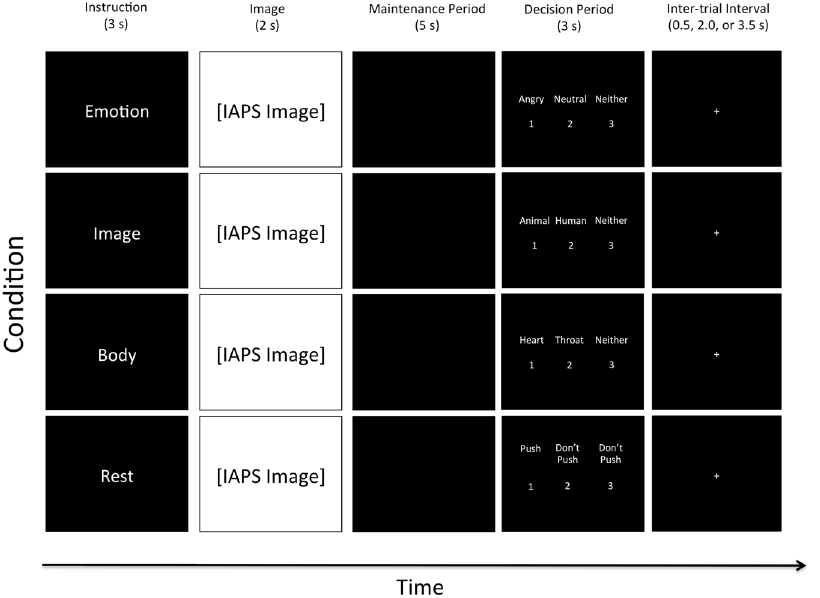
Figure 1. Illustration of the four task conditions. After the appearance of each instruction, an emotionally pleasant, unpleasant, or neutral image (from the International Affective Picture System [IAPS]) was presented followed by a maintenance period. All contrasts reported in this manuscript compare the 5-second maintenance periods between the “Emotion,” “Image,” and “Rest” conditions. Analyses of the “Body” condition will be presented in a separate manuscript. The decision period that followed included making a simple identification judgment from memory that included 3 options (where the correct answer was different depending on the instruction associated with that condition; described in greater detail in the text). Participants did not know what condition-specific options would be presented on a given trial, but could select “Neither” if the available options on that trial were both